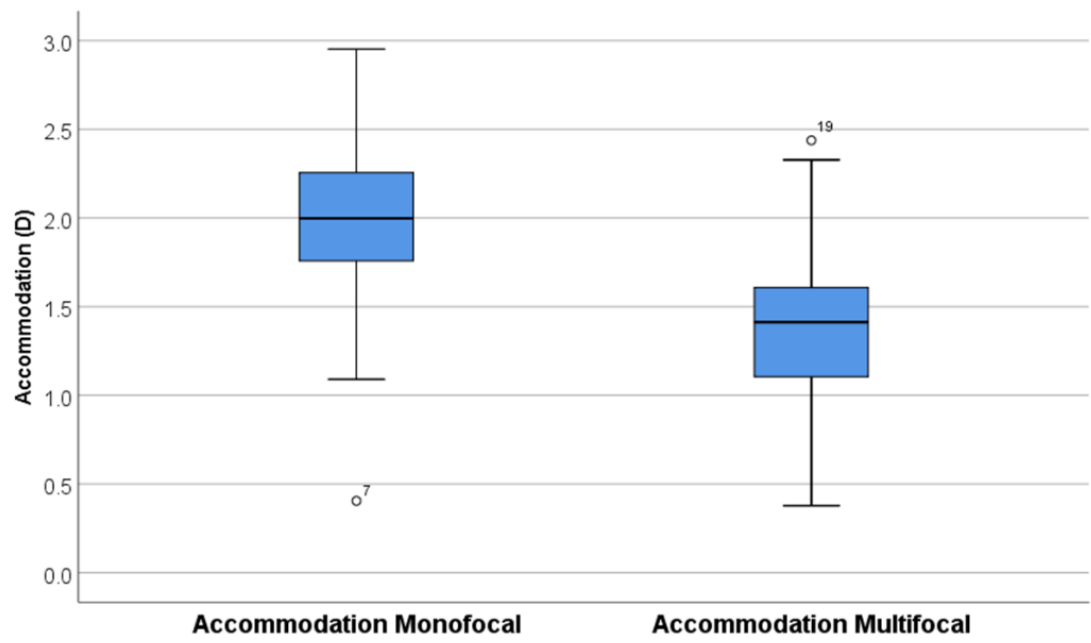
Figure 2. Boxplot of binocular accommodation at 40 cm.